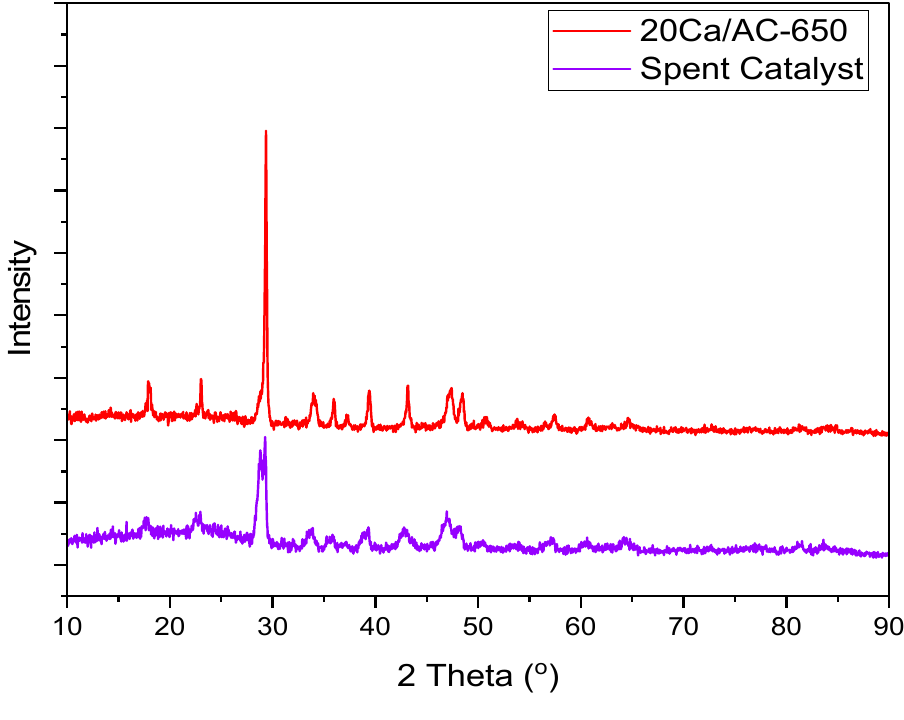
Figure 6. XRD of 20Ca/AC-650 and spent catalyst.